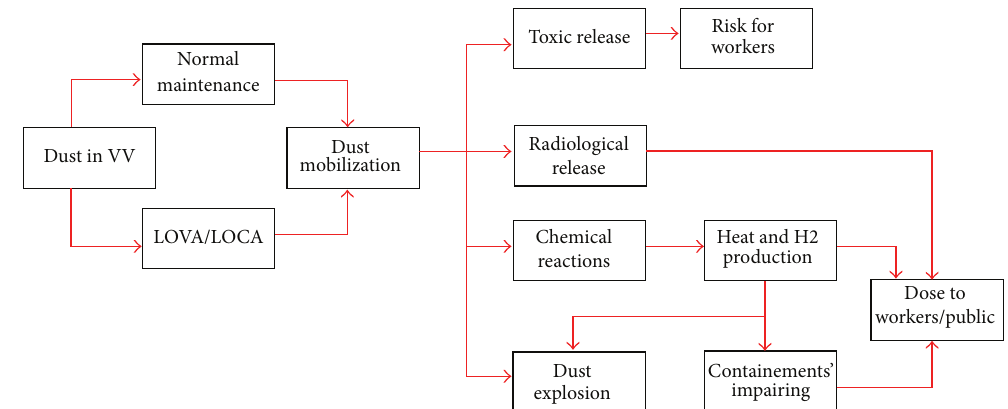
Figure 6: Map of risk due to dust mobilization.